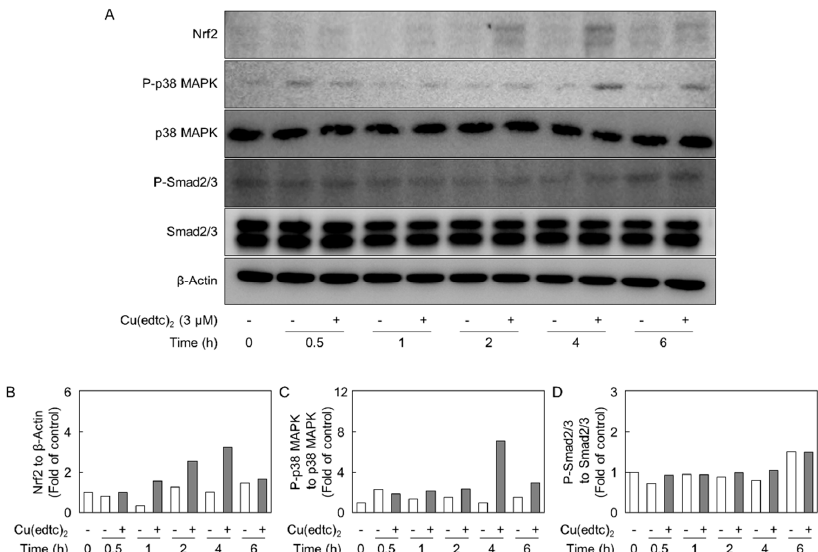
Figure 5. Effects of Cu(edtc) 2 on the expression of NF-E2-related factor2 (Nrf2) and phosphorylation of p38 mitogen-activated protein kinase (MAPK) and Smad2/3 in vascular endothelial cells. The cells were incubated at 37 °C for 0.5, 1, 2, 4, and 6 h in the presence of Cu(edtc) 2 (3 µM). ( A ) Cell lysates were then subjected to western blotting; ( B – D ) the ratio of the intensity of Nrf2, phosphorylated p38 MAPK (P-p38 MAPK), and phosphorylated Smad2/3 (P-Smad2/3) in ( A ) to those of β -Actin, p38 MAPK, and Smad2/3, respectively; values are means of two replicates from two independent experiments ( B – D ).